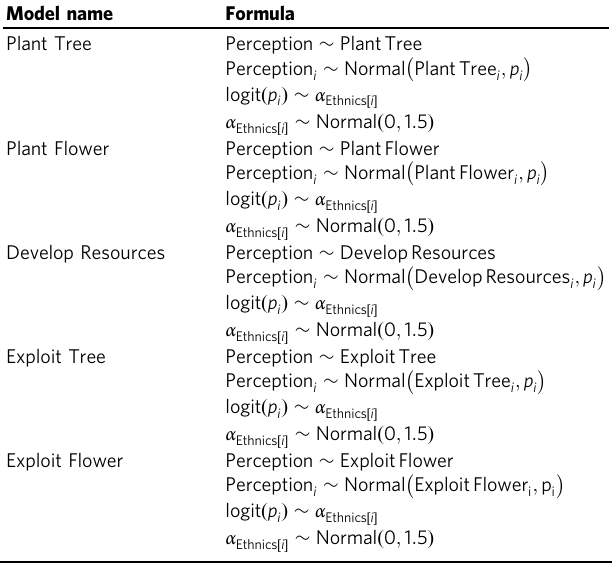
Table 3 Mathematical formula of examined models.